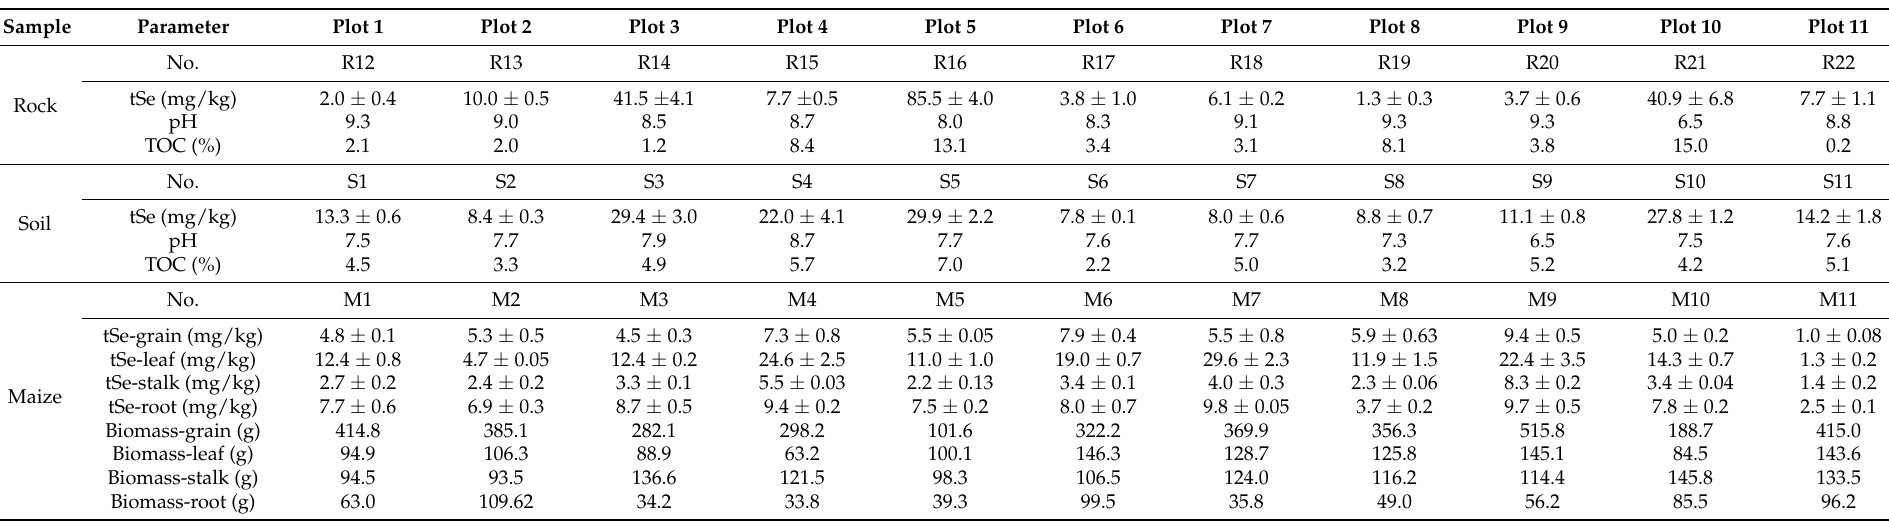
Table 1. The concentration of tSe in rocks, soils, and pH and TOC, as well as tSe in maize organs and biomasses (dry weight per plant). Sample Parameter Plot 11